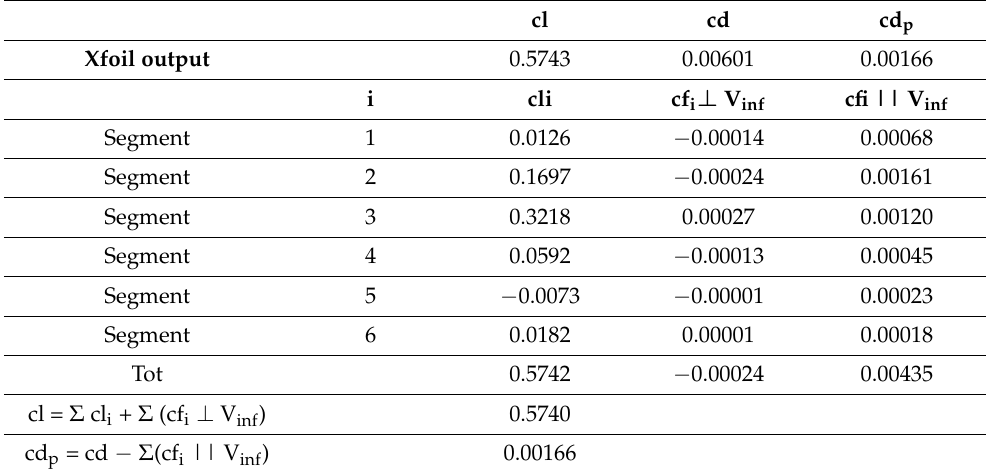
Figure 29. NACA 23012 Xfoil 6.99 polar results — Re 3.5 × 10 6 , alfa 4°. Table 14. NACA 23012 Xfoil 6.99 aerodynamic results segment-wise distribution (Re = 3.5e 6, 𝛼 = 4°).